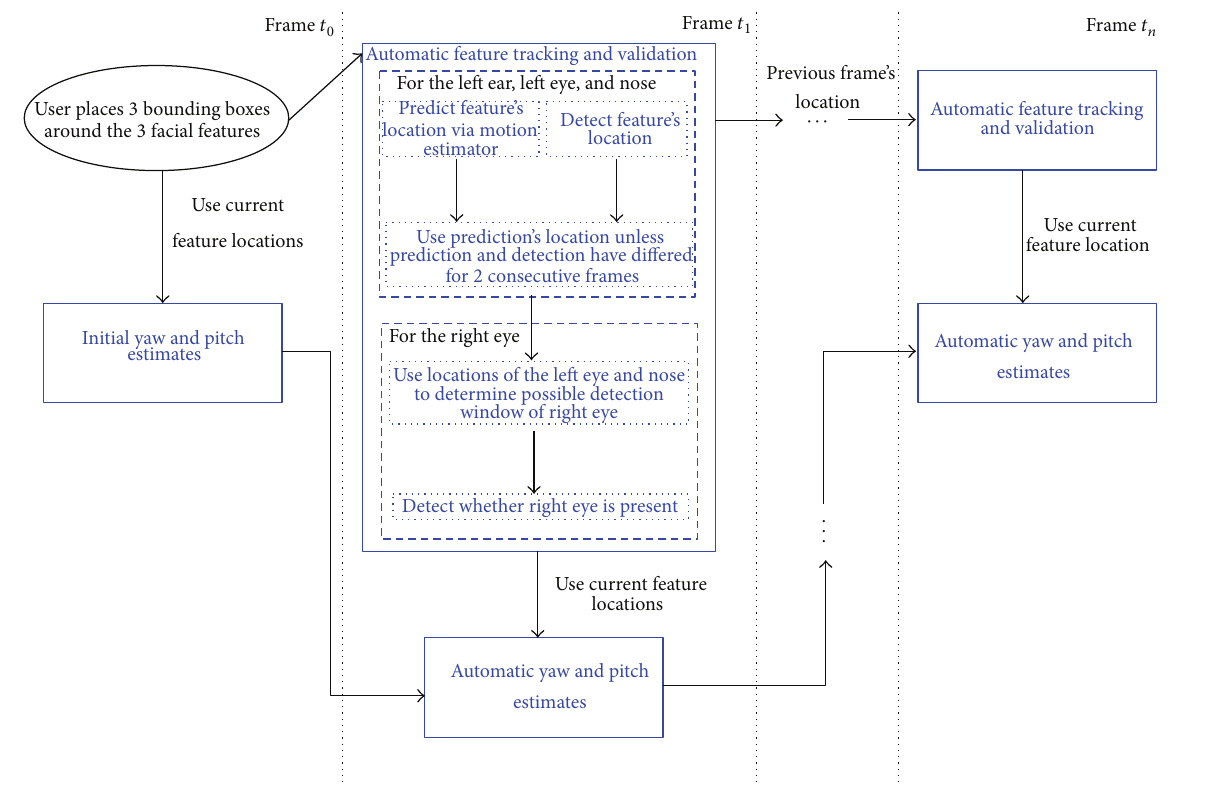
Figure 6: Data flow of the system for estimating yaw and pitch motions. We only require the user to place a bounding box around the left ear, left eye, and nose in the first frame of the video segment (black ellipse at time 𝑡 0 ). All the subsequent steps occur in a fully automatic fashion (blue blocks).